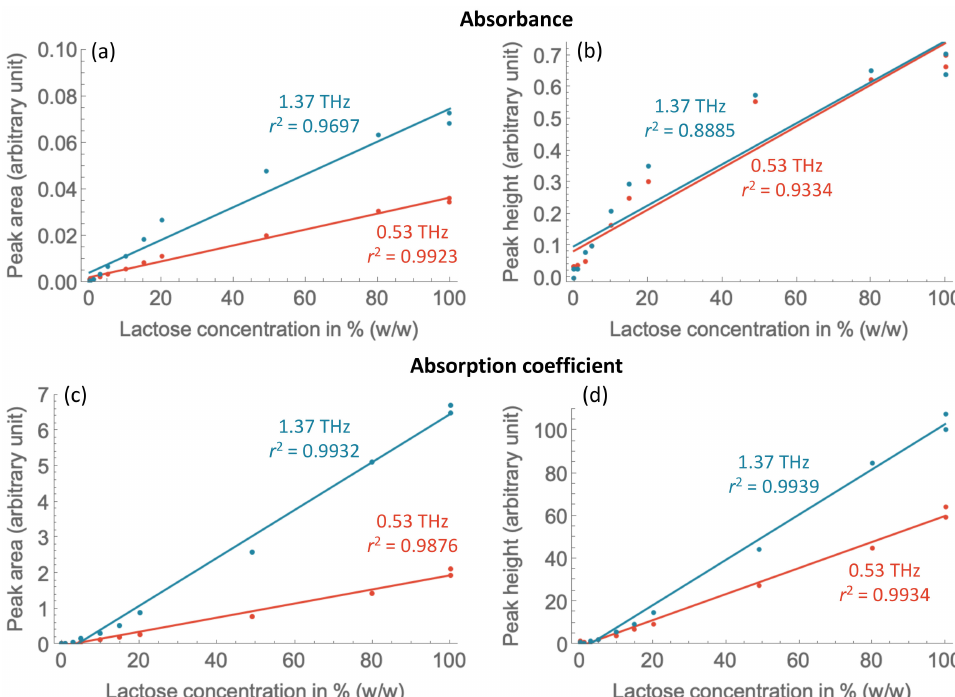
Figure 3. The relationship between α -lactose monohydrate concentration and ( a ) absorbance peak area, ( b ) absorbance peak height, ( c ) absorption coefficient peak area and ( d ) absorption coefficient peak height of the absorption peaks at 0.53 THz and 1.37 THz, from measurements in nitrogen atmosphere. Simple linear regression analysis [19] was applied on the datasets and results are reported in Table 2. Table 2. Equation of trendline and RMSE of different prediction models for lactose quantification.